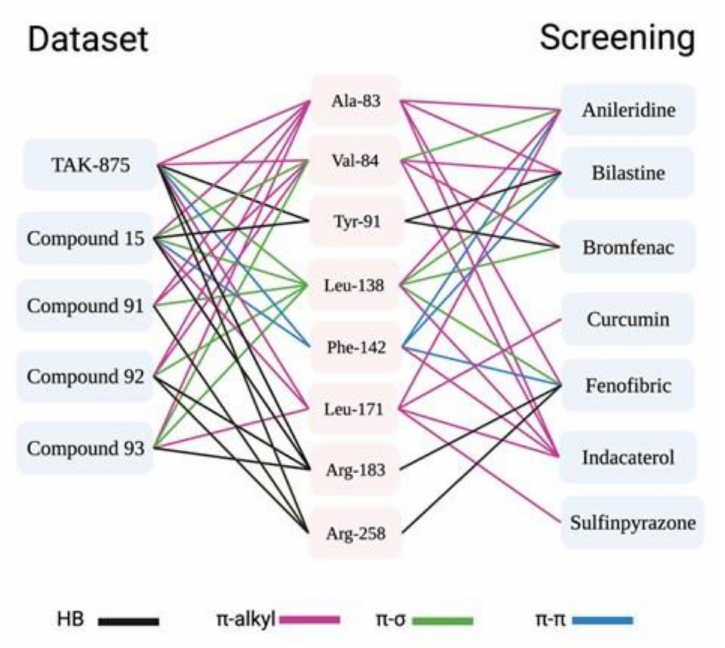
Figure 6. Interactions between FFA1 and selected molecules of the database and screening (created with